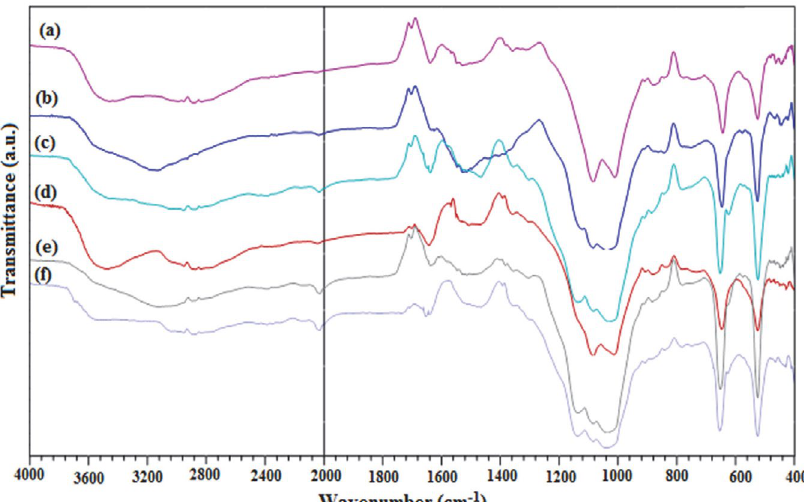
Figure 3. FTIR spectra of (a) undoped YbPO 4 (b) YbPO 4 :Tb 3+ (SC) (c) YbPO 4 :Tb 3+ (HT) (d) YbPO 4 :Tb 3+ (ST) (e) YbPO 4 :Tb 3+ (Sac) (f) YbPO 4 :Tb 3+